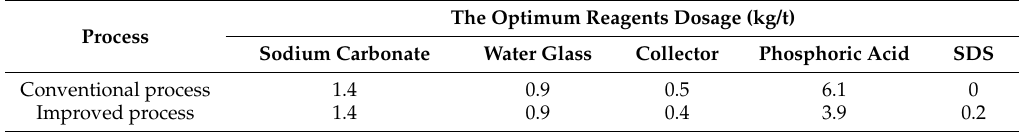
Table 7. Concentrate indices of two